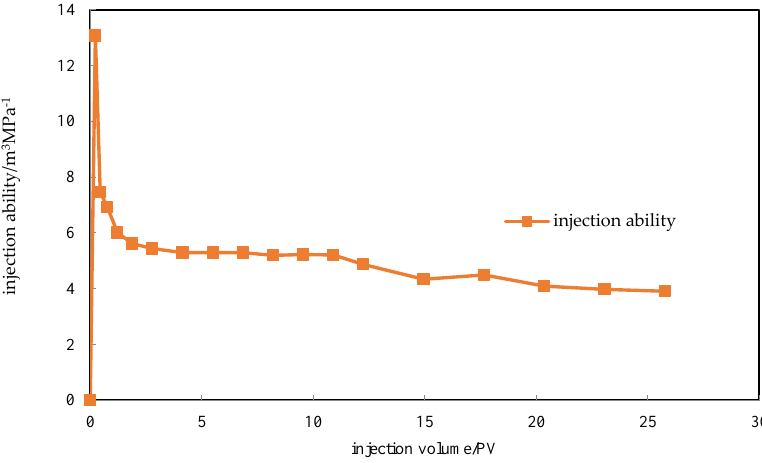
Figure 9. Injection ability and multiple injection relationship diagrams.